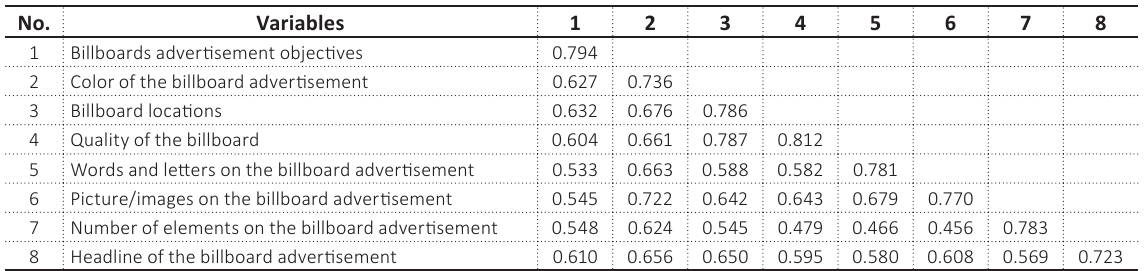
Table 3. Correlations of study variables